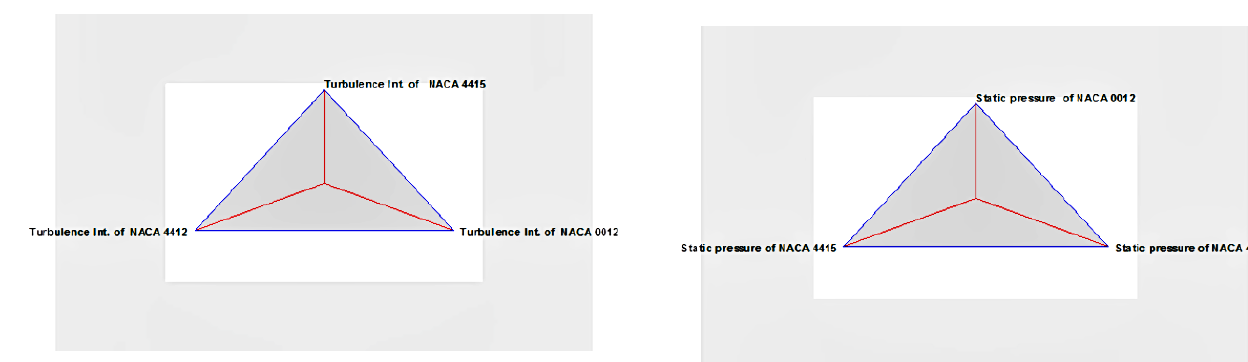
Figure 8. Sunray plots with values of static pressure blade tip sizes of 0.1, 0.15, and 0.2m and blade twist angles of 0, 3, 6, 9, 12, and 15 ◦ .